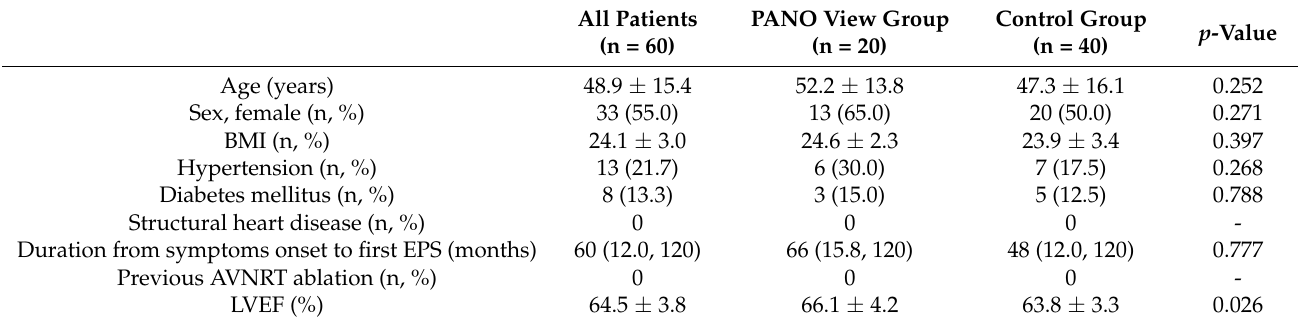
Table 1. Baseline characteristics between two groups.